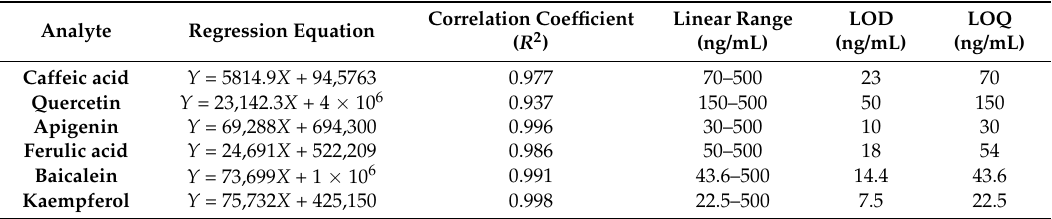
Table 3. The regression equation, correlation coefficient, linear ranges, LODs, and LOQs of the six tested components in AR using